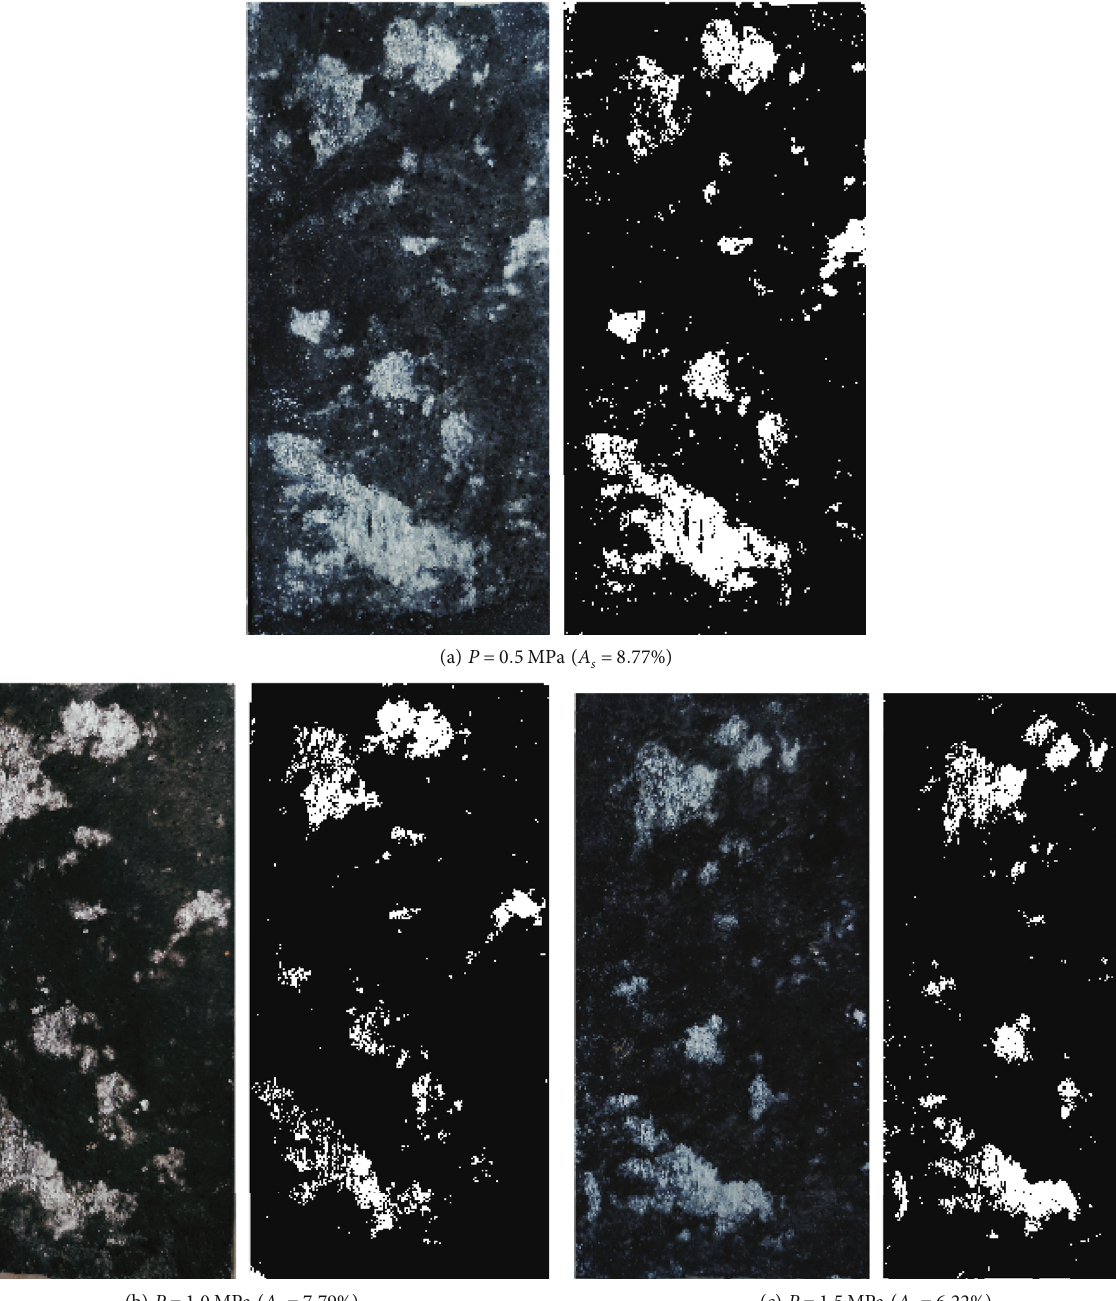
Figure 16: Failure condition of the joint when the initial normal stress is 2